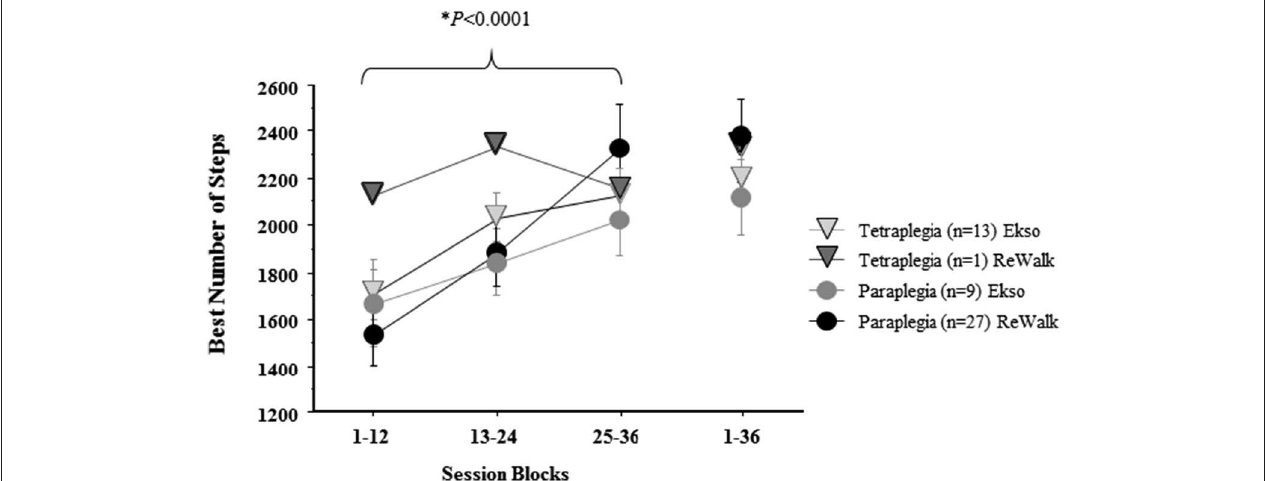
FIGURE 4 | The average best number of total steps in a session block by level of SCI by device. The mean ± standard error of the best number of total steps/sessions achieved during each 12-session block by Tetra (Tetraplegia), Para (Paraplegia) and by device (ReWalk, Ekso) are reported. The overall best number of steps in a single session is reported for 1–36. The number of steps significantly increased by session block, but no significant effects were found for combination of Tetra/Para and Device.